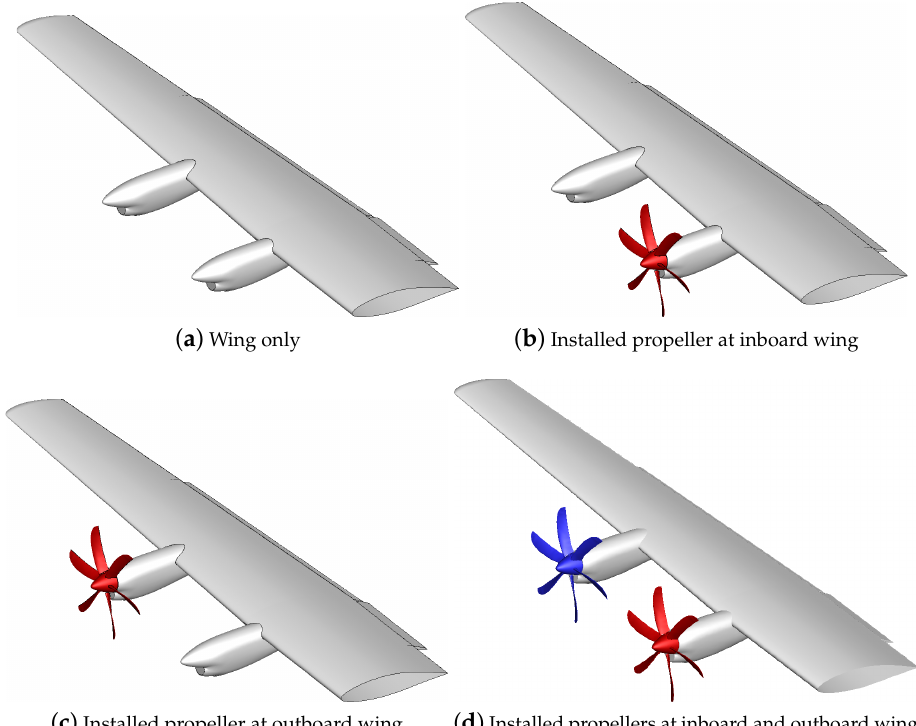
Figure 4. Test cases include no propeller; propeller installed inboard; propeller installed outboard; and propellers installed on the inboard and outboard